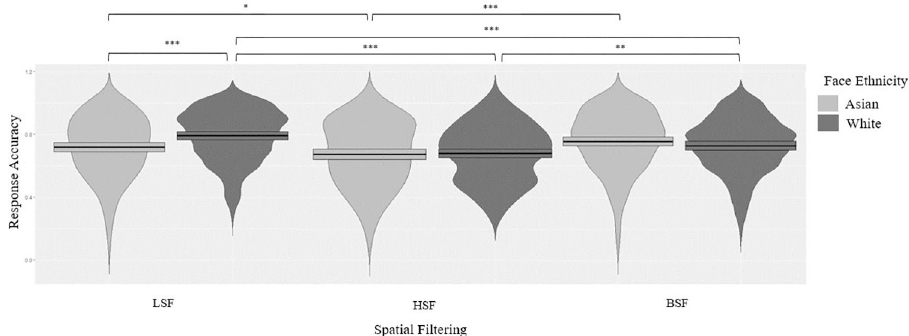
Fig 2. Response accuracy for European (White) and Asian faces plotted as a function of the spatial frequency condition (Broad-Spatial-Frequency, High-Spatial-Frequency, and Low-Spatial-Frequency) � p < .05. �� p < .005. ��� p <